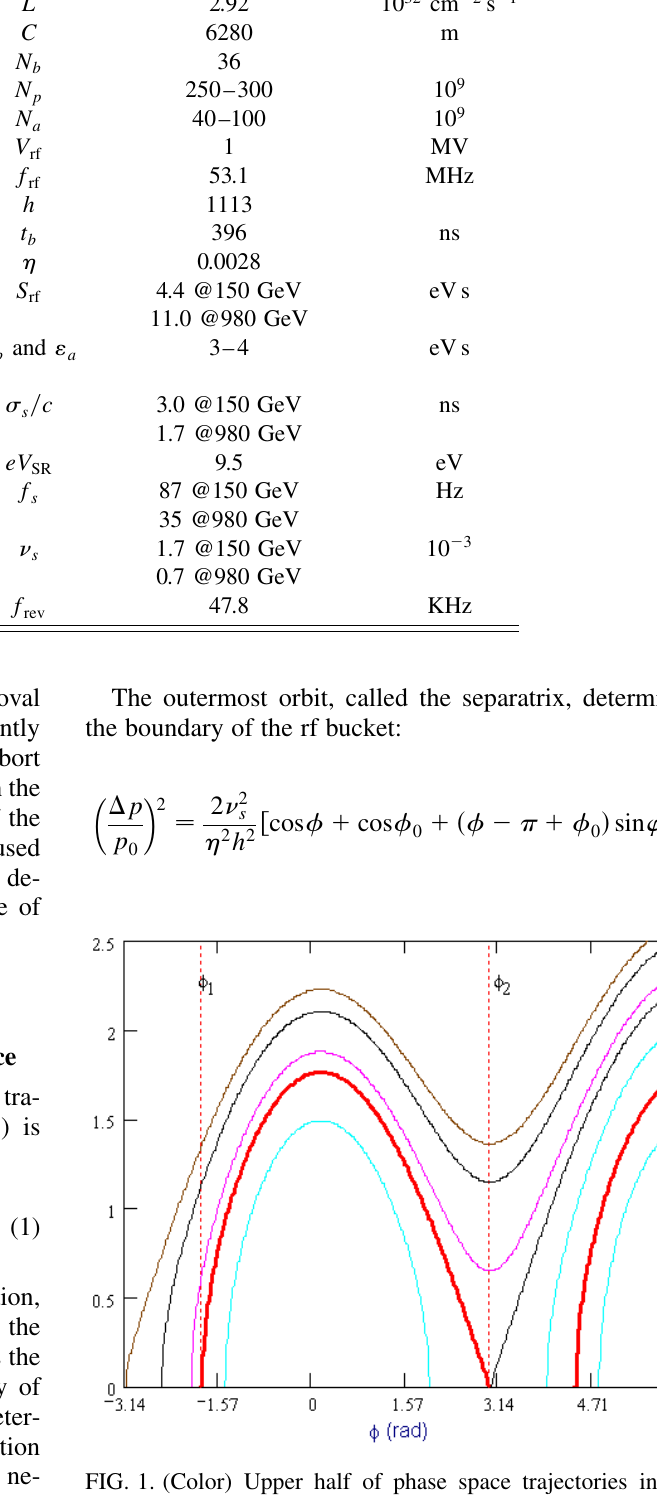
(cid:2) 0 : 15 . Momentum 0 (cid:7) (cid:1) p=p . s 0